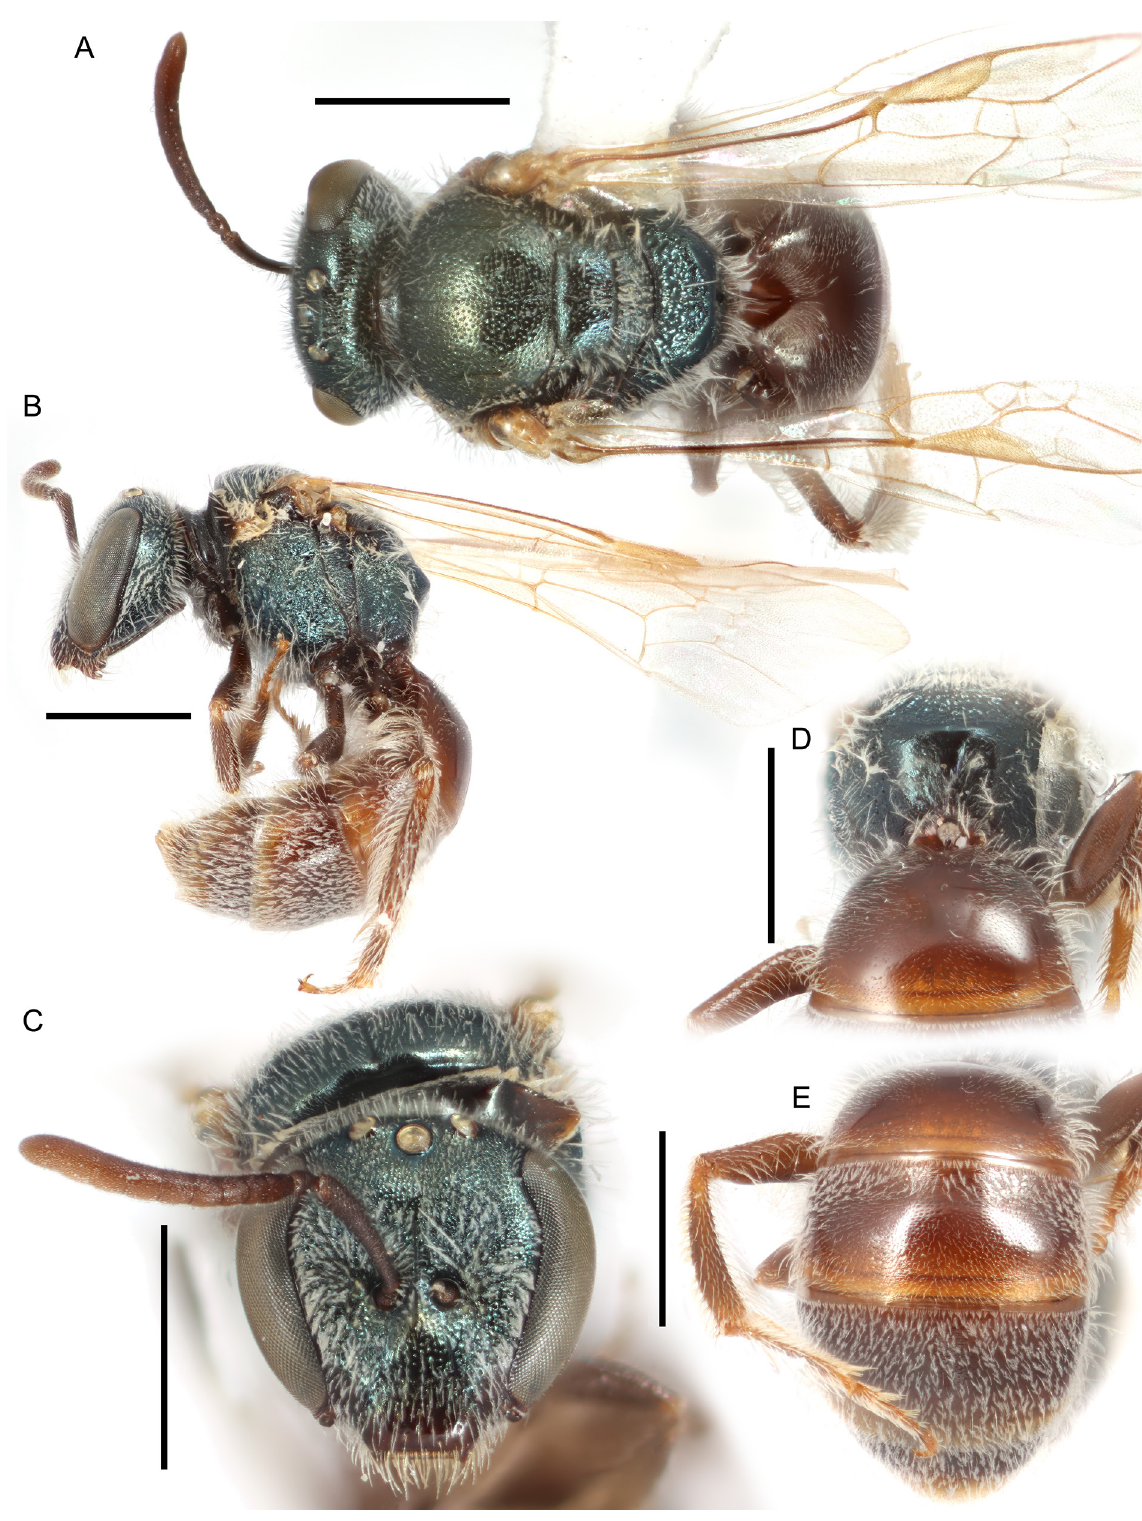
Fig. 36. Lasioglossum ( D. ) eophilus (Ellis, 1914), ♀. A . Dorsal habitus. B . Lateral habitus. C . Face. D . Propodeum. E . Metasoma. Scale bars: 1